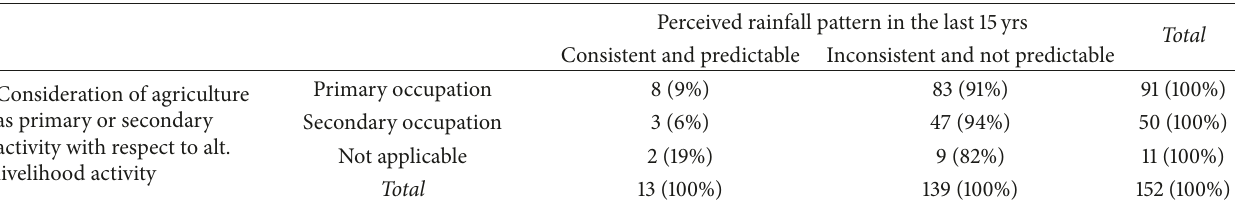
Table 2: Cross tabulation showing farmers switching to alternative livelihood activities as their main economic activity based on the consistency and predictability of